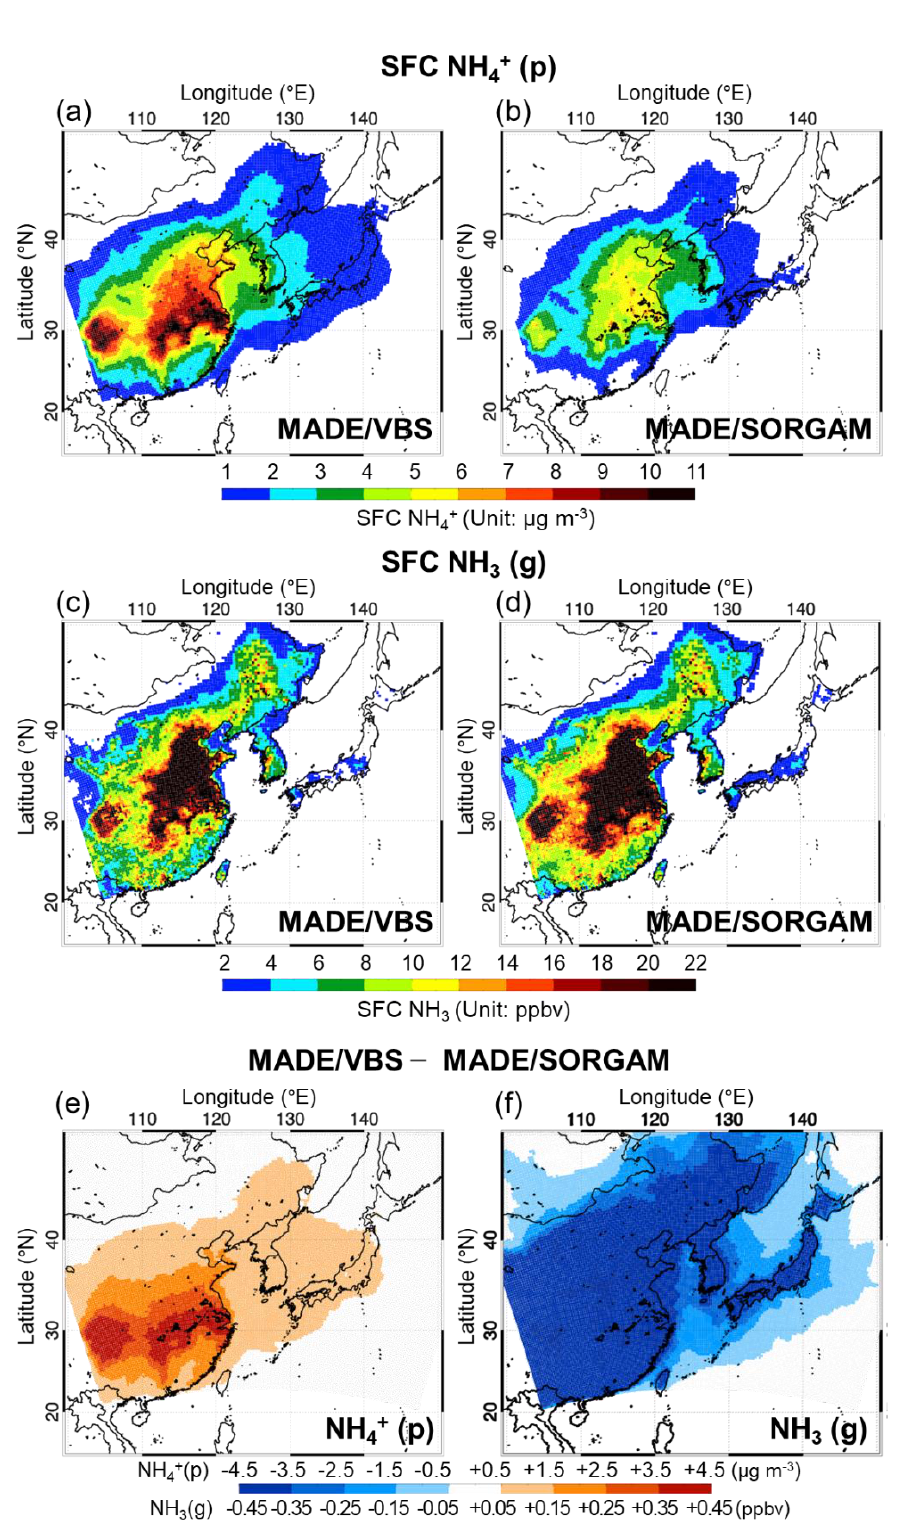
Figure 8. Comparisons of horizontal distributions for ammonium ( a , b ), NH 3 gas concentrations ( c , d ), and differences ( e , f ) between two modules, MADE/VBS and MADE/SORGAM, for ammonium (NH 4+ ) and NH 3 , respectively.